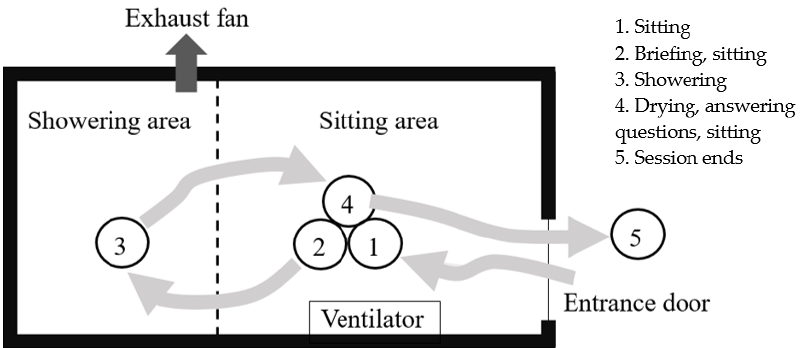
Figure 1. The bathroom (2.1 m × 1.5 m).